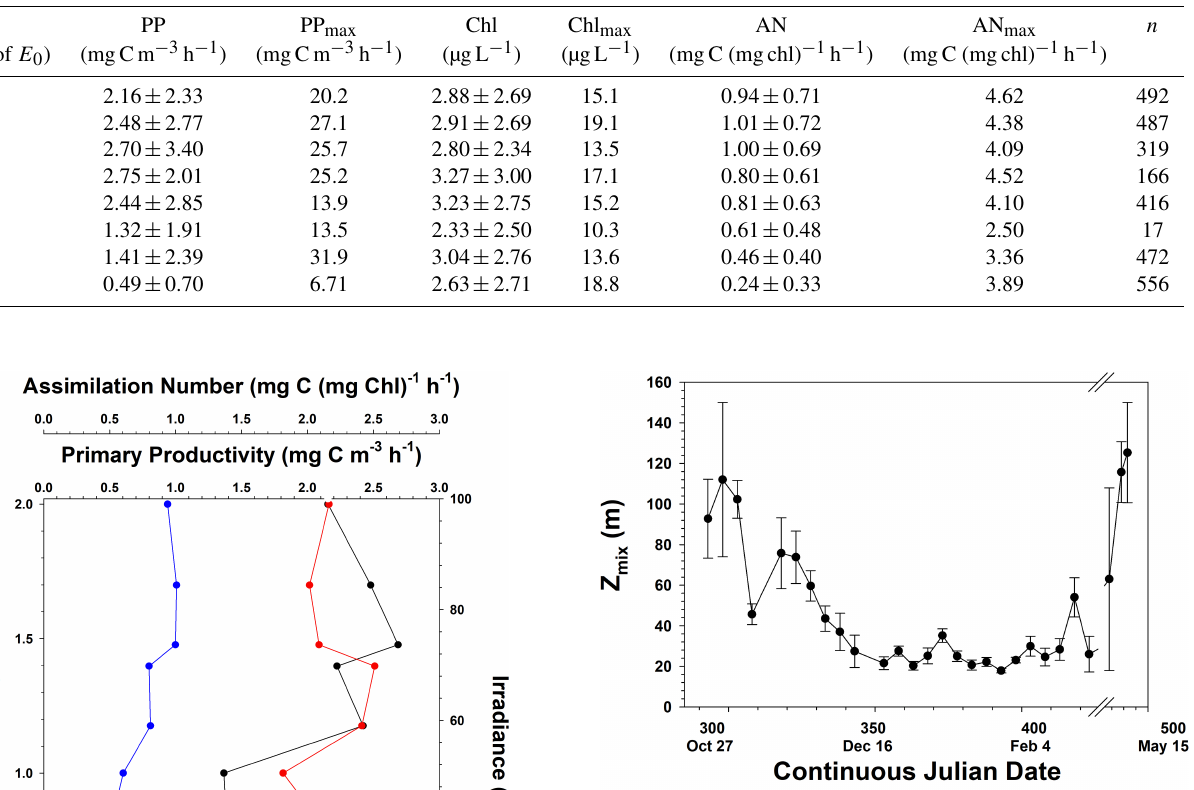
Earth Syst. Sci. Data, 14, 2737–2747,